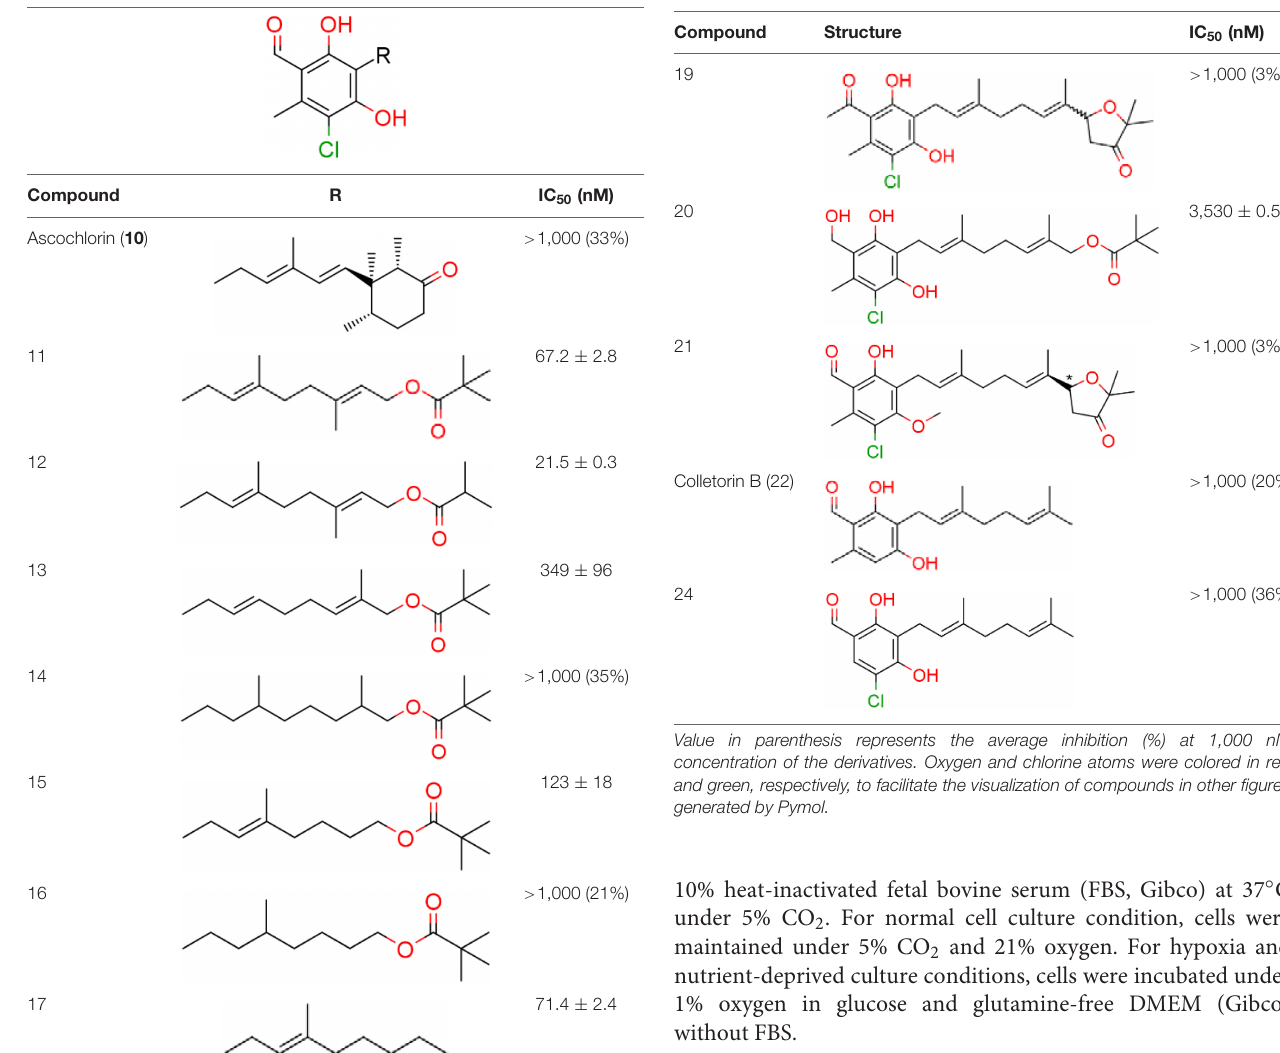
TABLE 2 | Inhibition of human DHODH by 1 derivatives with different linker structures.